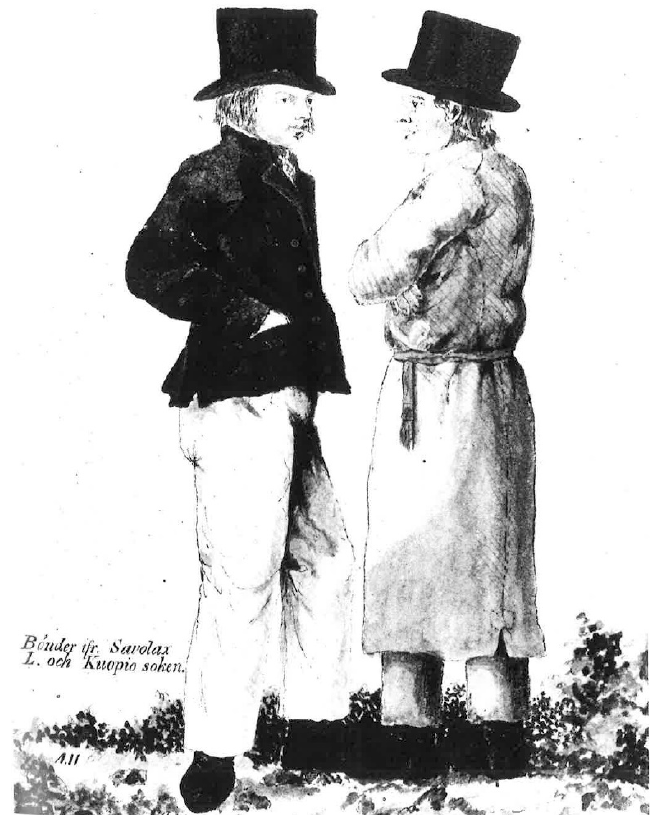
Figure 3. Peasant dress in Savonia in the 1820s. The man on the left wears a jacket much like the körtti jacket. Watercolour by Adolf Hårdh (1807–1855).